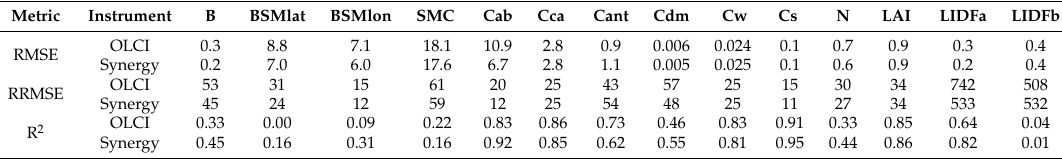
Table 3. Metrics of retrieval on synthetic dataset. Definitions of parameters can be found in Table 1. Metric